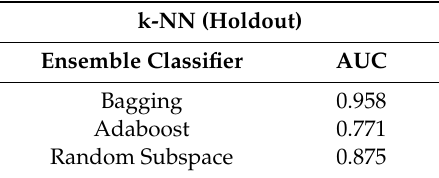
Table 5. ROC evaluation of ensemble with k-NN base classifier.